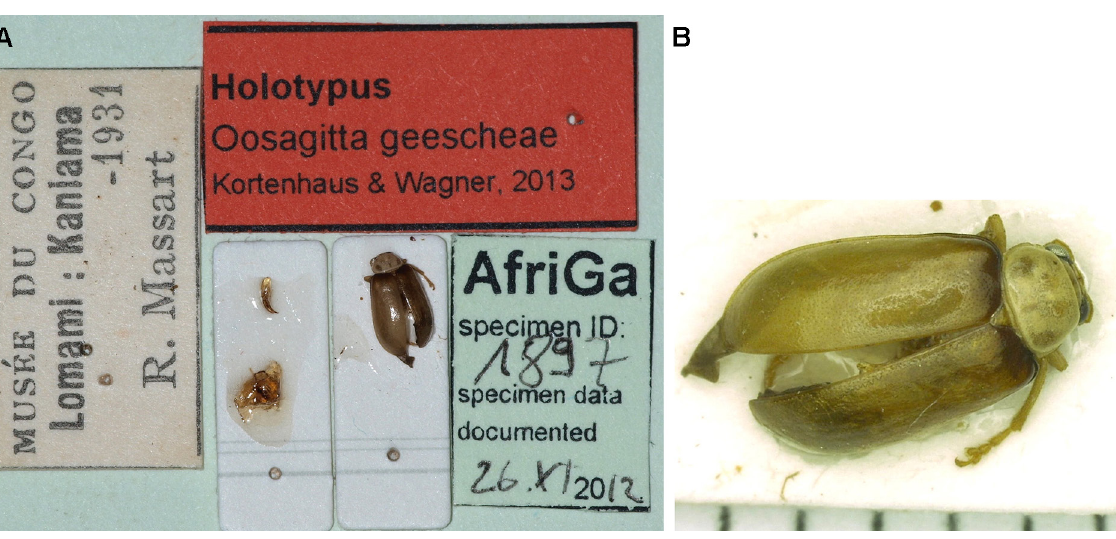
Fig. 22. Holotype of O. geescheae sp. nov. A . Overview with labels. B . Close-up of